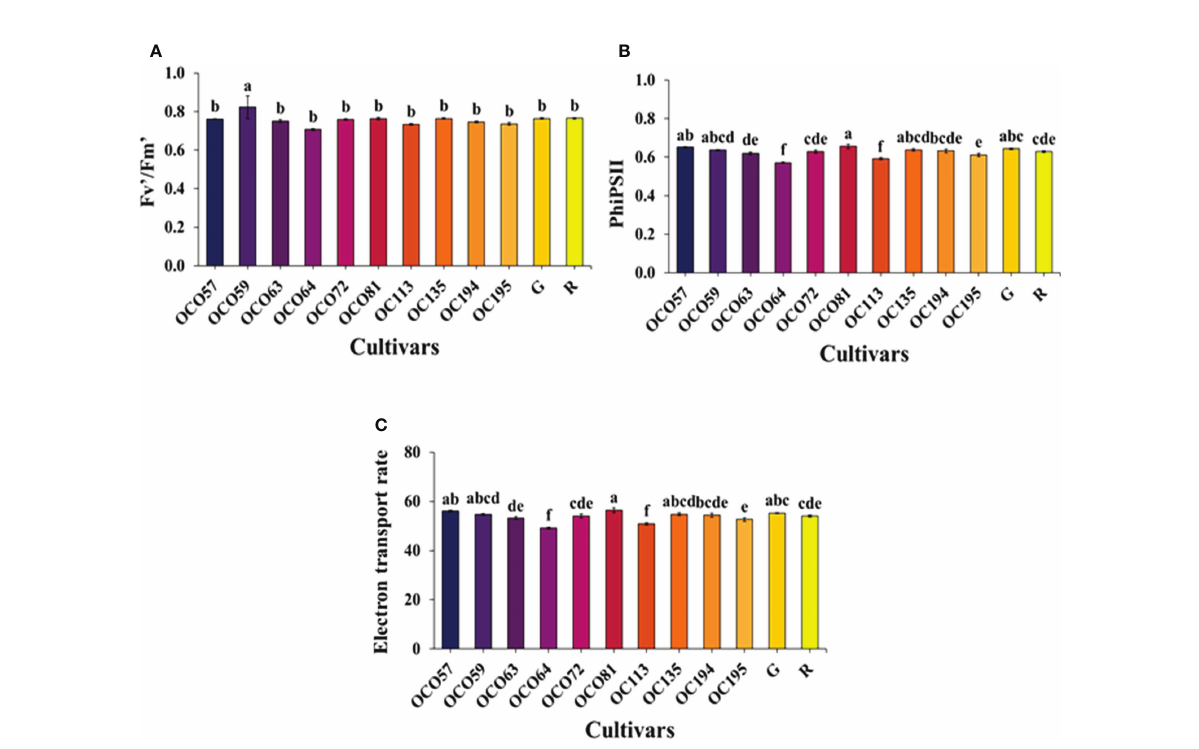
FIGURE 4 Photosynthetic light reaction parameters, F v ′ /F m ′ (A) , PhiPSII (B) , and ETR (C) of Thai holy basil cultivars/accessions at the fl owering stage. R and G represent the red and green commercial cultivars, respectively. Bars represent standard error. Values are represented as mean ± SE ( n = 4). ANOVA was performed, followed by a mean comparison with DMRT. Letters above bars show the signi fi cant difference of means at P <